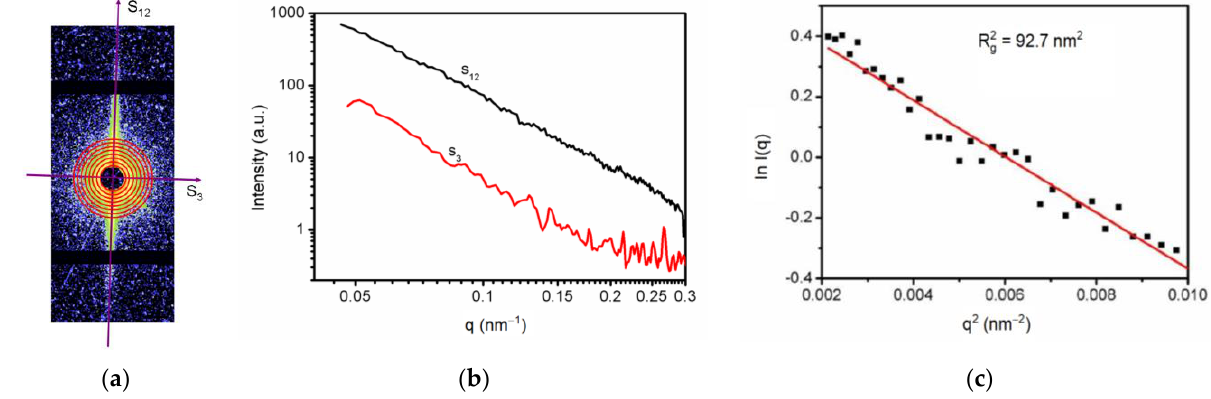
Figure 4. SAXS data processing: ( a ) Scattering direction punctuating, ( b ) SAXS curve of RDX single crystals along the scattering direction S 12 and S 3 , ( c ) SAXS data analyzing by the Guinier fitting curve along the S 12 .